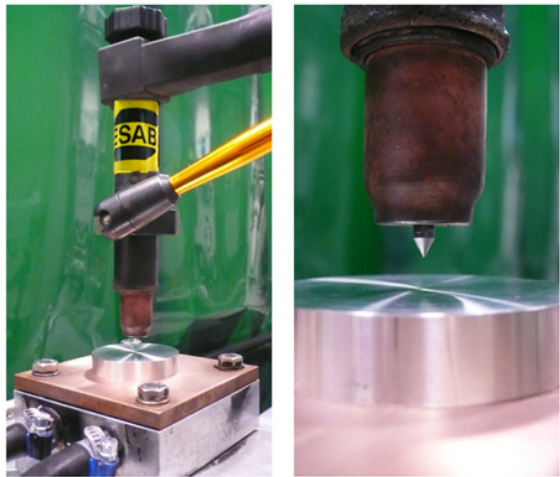
Figure 1. Tungsten inert gas (TIG) welding device.